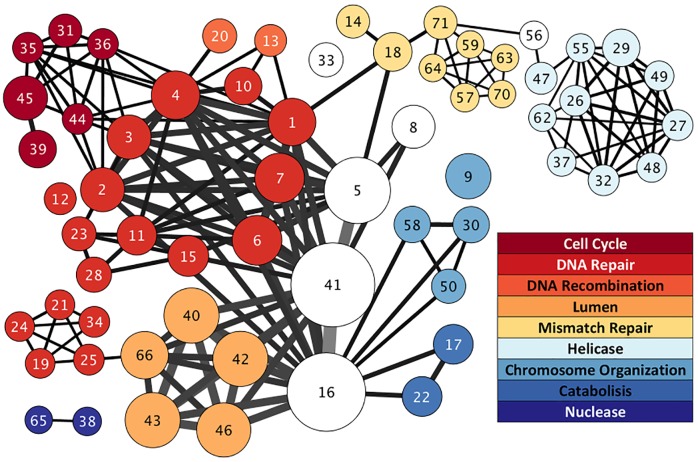
Functional enrichment network of recessive COSMIC cancer genes highlights DNA repair and cell cycle control.Each node in this network represents a group of functionally related genes as returned in DAVID (gene ontology, orthology, functional annotations, etc.). The size of the node represents the number of genes in it. Links between nodes represent gene overlaps between groups, with the width representing the number of genes. Node colors indicate the general functional categories defined in the legend revealing an additional layer of clustering of gene groups. The number in the node indicates the group label as given in S2 Table. Further details of these enrichments for each node are elaborated in S2 Table. For convenience, only nodes with p < 0.002 and FDR < 0.05 are plotted.